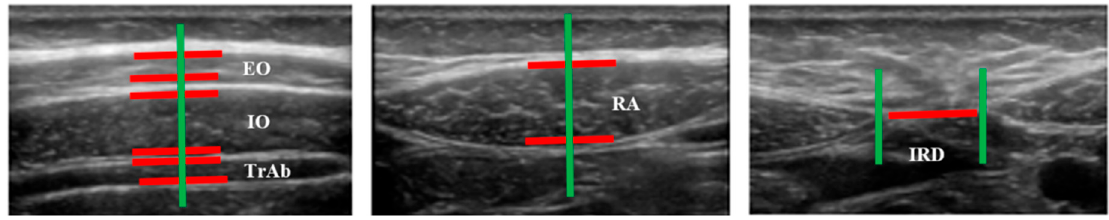
Figure 2. Measurements of muscle thickness and the IRD of the abdominal wall.